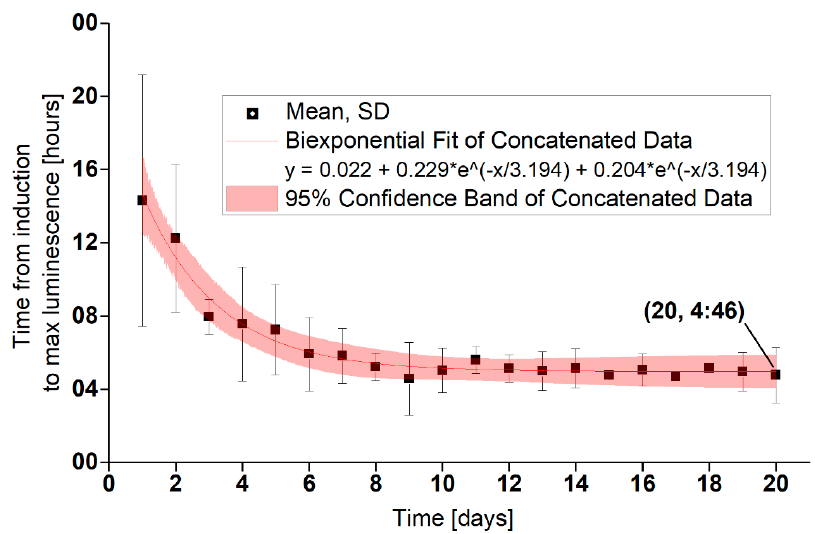
Figure 7. Time of the first bioluminescence maxima. Aggregated data from the five OFEs plus one OFE from reference [19].